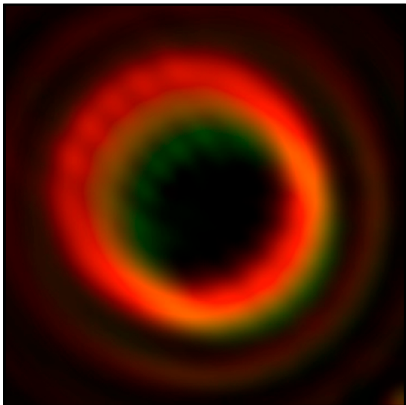
Figure 4. Simulated supercontinuum vortex generated from the superposition of individual vortices with wavelengths λ = 520 nm, 570 nm, 600 nm and 650 nm.